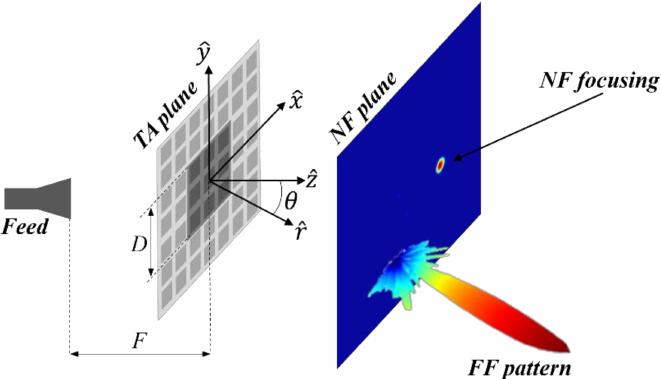
Figure 1. Transmitarray antenna with both NF and FF radiation